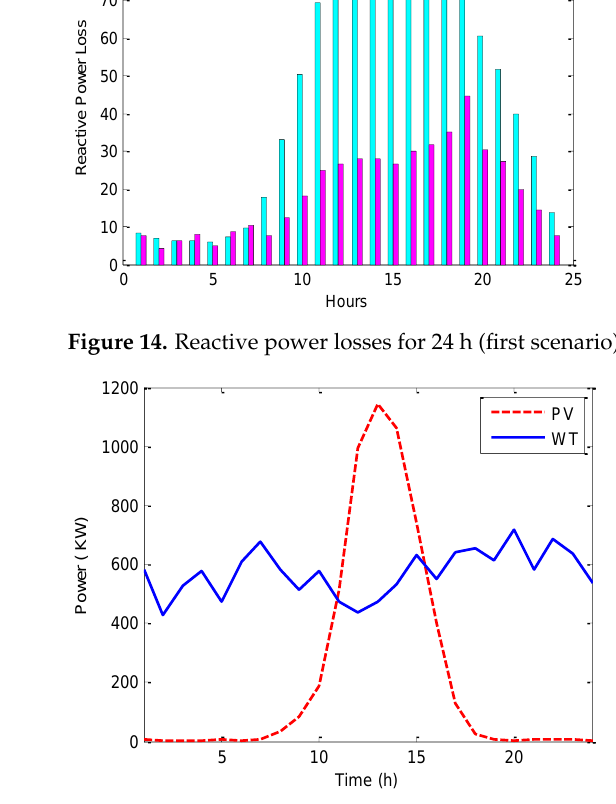
Figure 15. Power produced by RES for 24 h (first scenario).